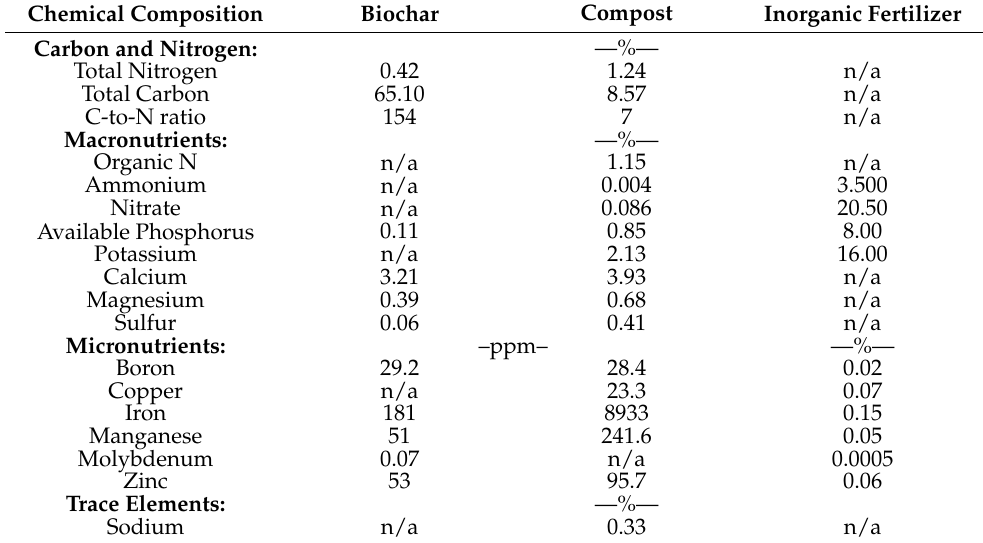
Table 2. Chemical properties of amendments prior to addition of native soil and water. The mineral composition of the inorganic fertilizer was sourced from the product label. Results for biochar and composted manure were obtained through laboratory testing. Use of “n/a” in the table indicates that a specific element was not provided with the laboratory report or product label but does not necessarily suggest that the element is entirely